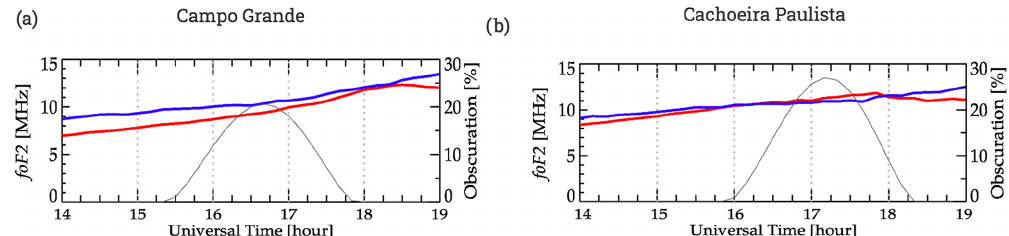
Figure 6. F region frequency ( fo F2) in (a) CG and (b) CXP between 14:00 and 19:00UT. These parameters are presented by the blue line for the quietest day of the month (4 December 2020), and the red line to the solar eclipse on 14 December 2020. The grey line represents the solar eclipse obscuration for each region in percent.